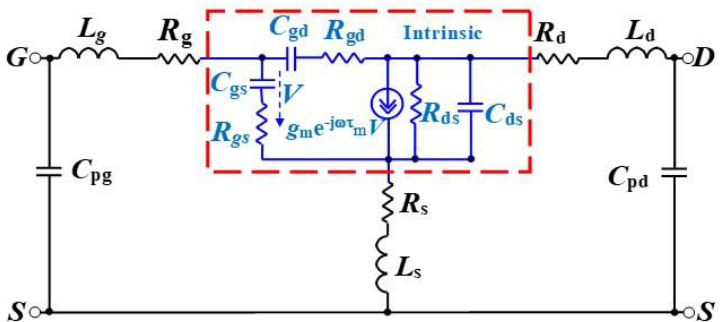
Figure 7. Equivalent-circuit model for the studied GaAs and GaN HEMTs.